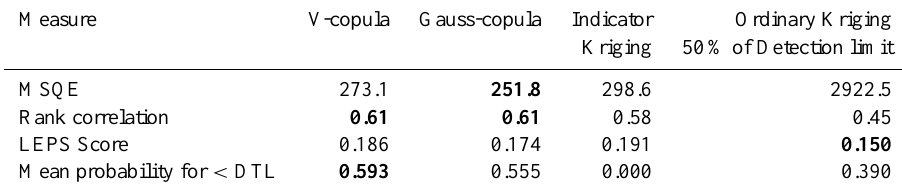
Table 5. Cross validation results for Chloride with 45% artificial censoring.